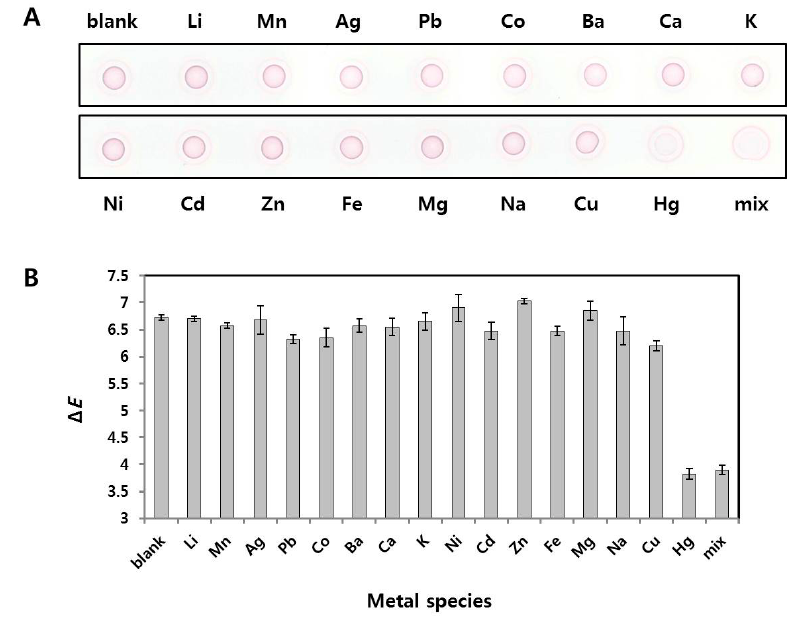
Figure 5. Selectivity of the radial flow assay for Hg 2+ : ( A ) Digital scanned image of red spots formed on NC-based paper. The final concentration of each metal ion was 1 µM; and ( B ) Color intensities ( ∆ E ) of the spots as measured by a portable spectrophotometer ( n = 3).